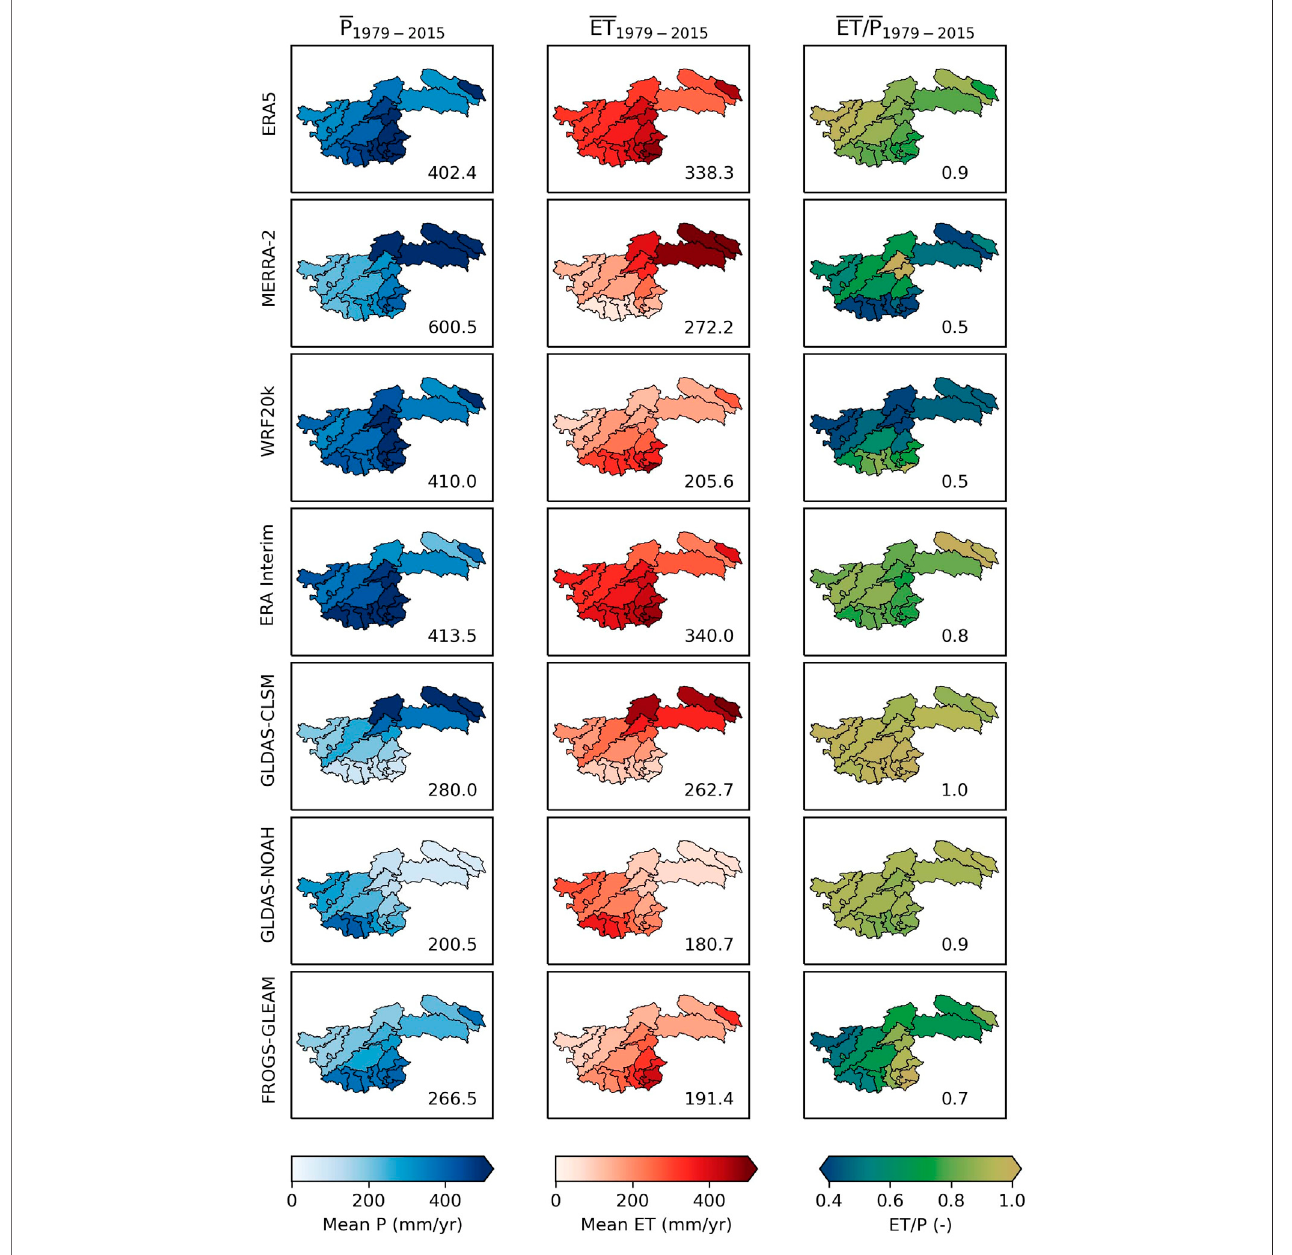
FIGURE 5 | Mean P and ET for the period 1979 – 2015 for each reanalysis product (with the exception of WRF20k, which ends in 2010, and the GLDAS reanalysis which ends in 2014). ET / P 1979 − 2015 is calculated as the annual mean ET for the period 1979 – 2015 divided by the annual mean P for the same period. The FROGS- GLEAM data correspond to P from FROGS and ET from GLEAM. The numbers in each subplot correspond to the area-weighted averages.